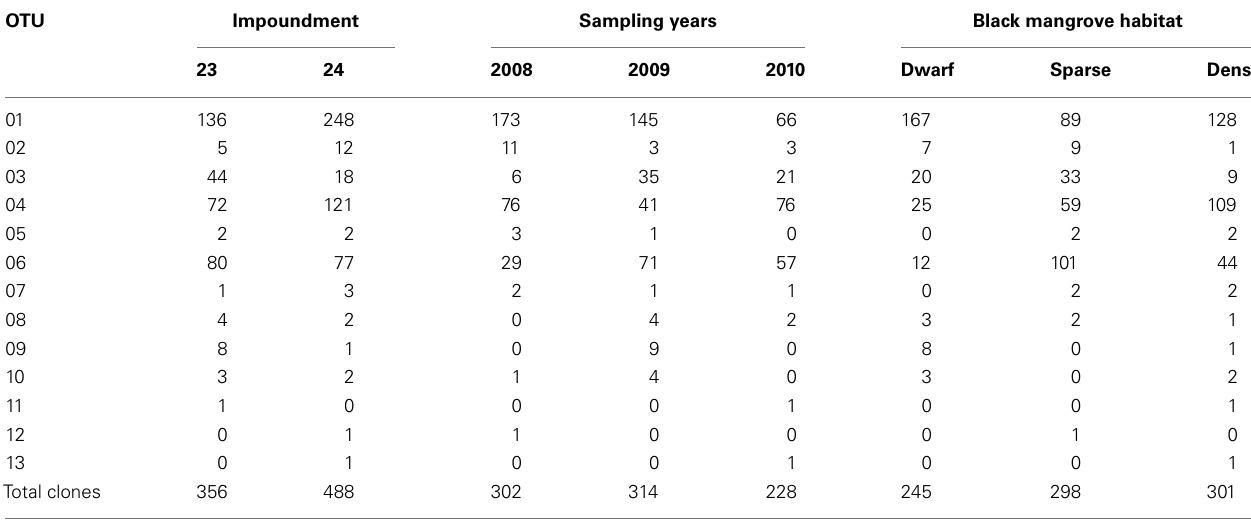
Table 1 | Distribution of clones related to ammonia-oxidizing betaproteobacteria over the different operational taxonomic units (OTUs), impoundments, sampling years, and Black mangrove